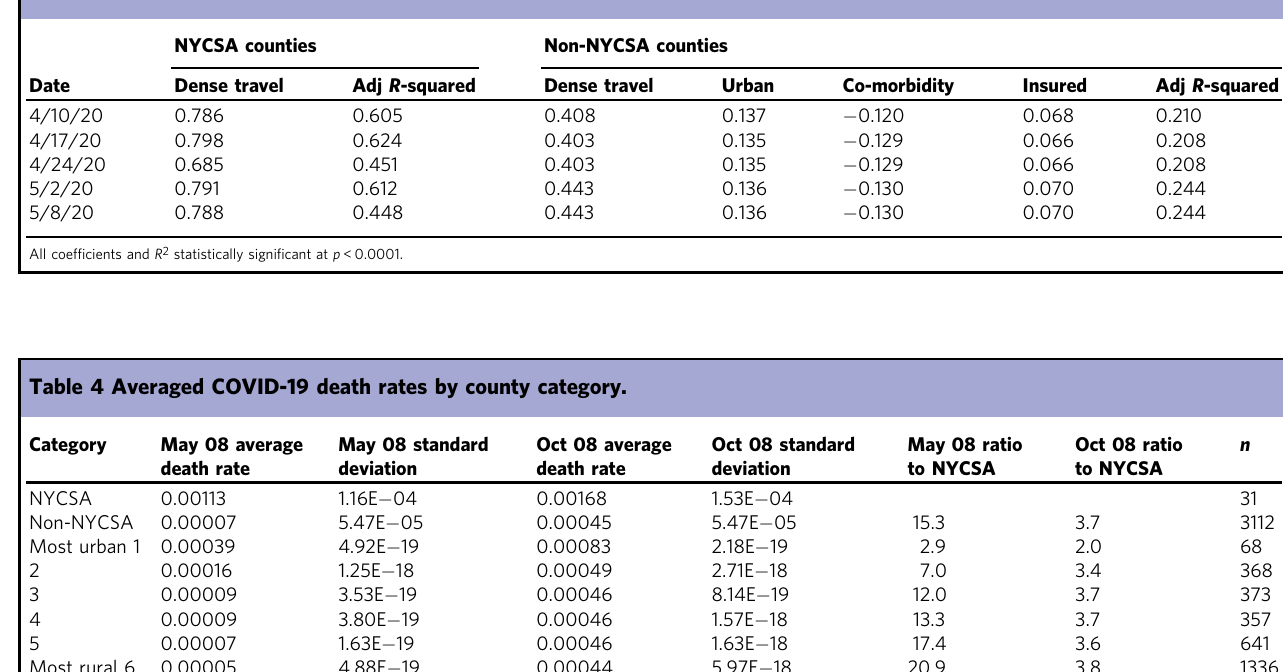
Table 3 Results of COVID-19 death factor models.